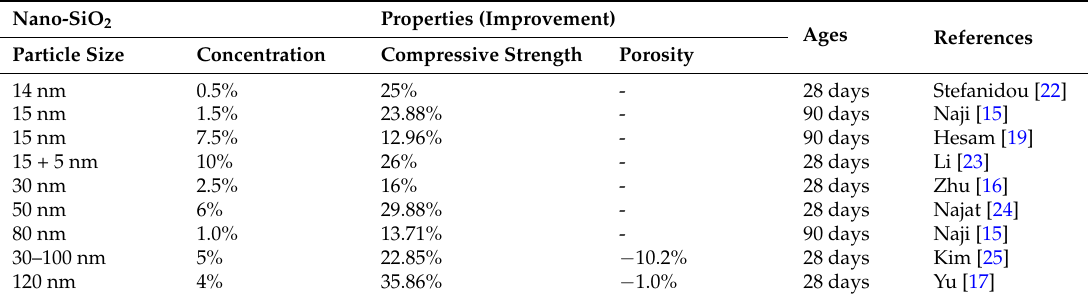
Table 1. Improvement of properties of cementitious composites with Nano-SiO 2 .